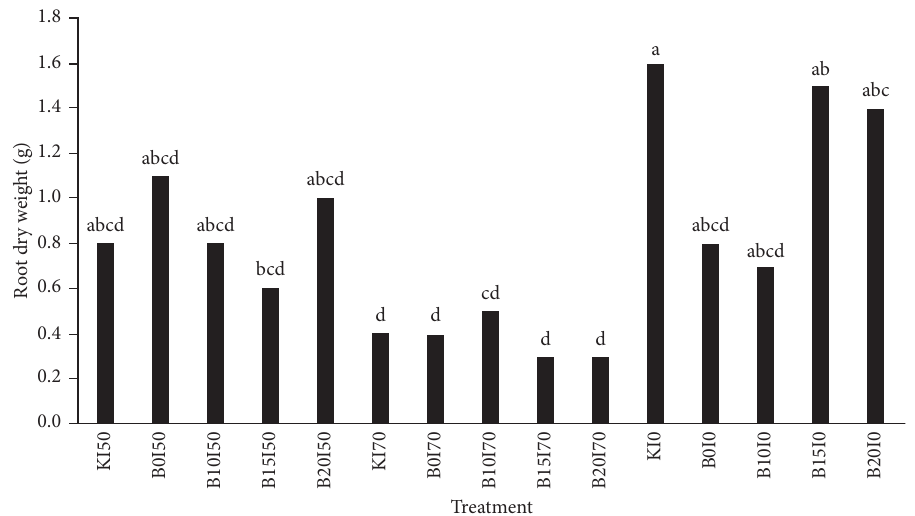
Figure 6: Root dry weight of longevity spinach ( Gynura procumbens ) plants as affected by biochar and shade application. Table 12: Effects of biochar and shade application on total N in plant tissues (%). Doses of biochar (ton ha − 1 ) Shade (%)